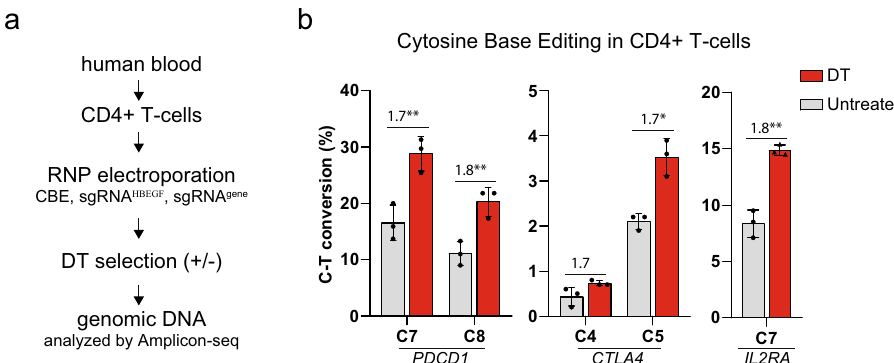
Fig. 6 Co-selection of CBE editing events in human primary T cells using DT selection. a Schema of the experimental setup. Total primary CD4 + T cells isolated from human blood, electroporated with CBE3 proteins, synthetic sgRNA10, and a synthetic sgRNA targeting a second genomic locus. The cells were cultivated with or without DT (untreated). b Analysis of NGS reads shown containing C – T conversion as a percentage of full-length reads in Amplicon-seq at indicated loci using depicted sgRNAs. The presented values and error bars show mean ± s.d. of n = 3 independent biological replicates. Relative fold changes are indicated in the graphs. * P < 0.05, ** P < 0.01, *** P < 0.001, Student ’ s paired t test (two-tailed). P values are calculated as below: in b , PDCD1 (C7 = 0.0040 and C5 = 0.0075), CTLA4 (C4 = 0.0955 and C6 = 0.0459), and IL2RA (C7 = 0.0071). Source data of Fig. 6b are provided as a Source data fi le.